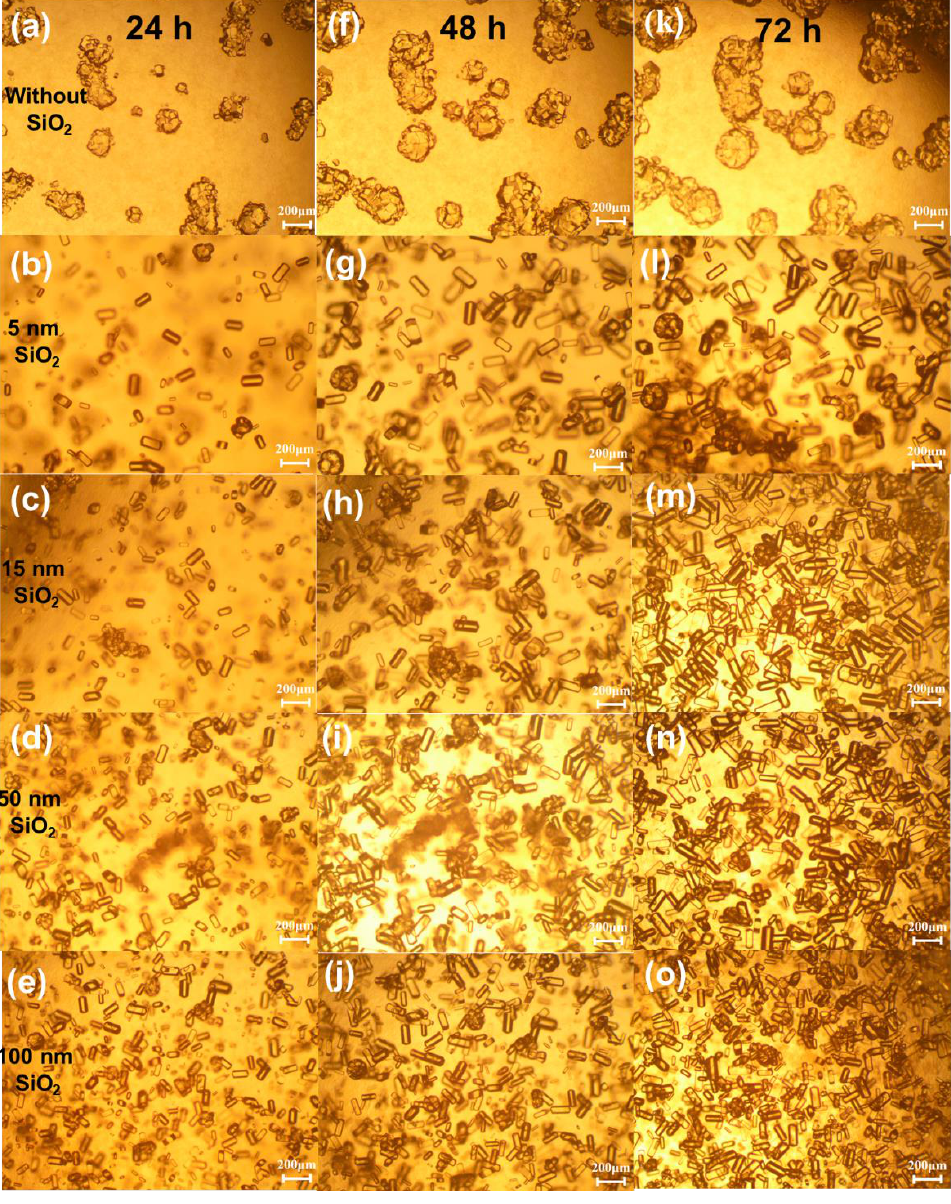
Figure 1. Microscopy photos of crystals obtained with SNP of different sizes. Conditions: 0.05 M, pH 4.5 sodium acetate buffer solution, 3 wt.% sodium chloride, 15 mg/mL lysozyme at 4 °C. Scale bar: 200 μm. ( a ): Crystal micrograph obtained under 24 h without SiO 2 ; ( b ): Crystal micrograph obtained at 24 h with 1 mg/mL 5 nm SiO 2 ; ( c ): Crystal micrograph obtained at 24 h with 1 mg/mL 15 nm SiO 2 ; ( d ): Crystal micrograph obtained at 24 h with 1 mg/mL 50 nm SiO 2 ; ( e ): Crystal micrograph obtained at 24 h with 1 mg/mL 100 nm SiO 2 ; ( f ): Crystal micrograph obtained under 48 h without SiO 2 ; ( g ): Crystal micrograph obtained at 48 h with 1 mg/mL 5 nm SiO 2 ; ( h ): Crystal micrograph obtained at 48 h with 1 mg/mL 15 nm SiO 2 ; ( i ): Crystal micrograph obtained at 48 h with 1 mg/mL 50 nm SiO 2 ; ( j ): Crystal micrograph obtained at 48 h with 1 mg/mL 100 nm SiO 2 ; ( k ): Crystal micro- graph obtained under 72 h without SiO 2 ; ( l ): Crystal micrograph obtained at 72 h with 1 mg/mL 5 nm SiO 2 ; ( m ): Crystal micrograph obtained at 72 h with 1 mg/mL 15 nm SiO 2 ; ( n ): Crystal micrograph obtained at 72 h with 1 mg/mL 50 nm SiO 2 ; ( o ): Crystal micrograph obtained at 72 h with 1 mg/mL 100 nm SiO 2 .